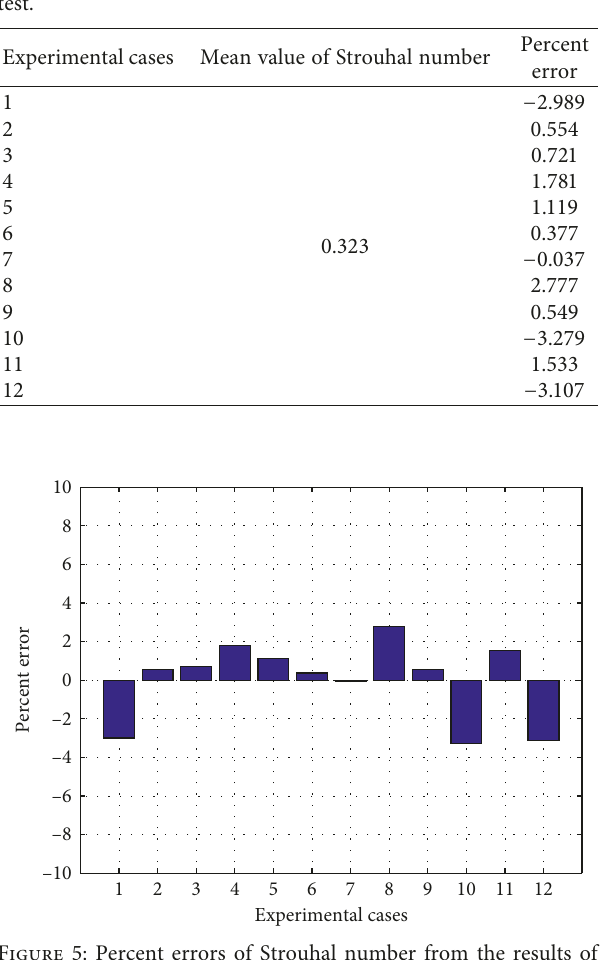
Figure 5: Percent errors of Strouhal number from the results of dynamic wind tunnel test.